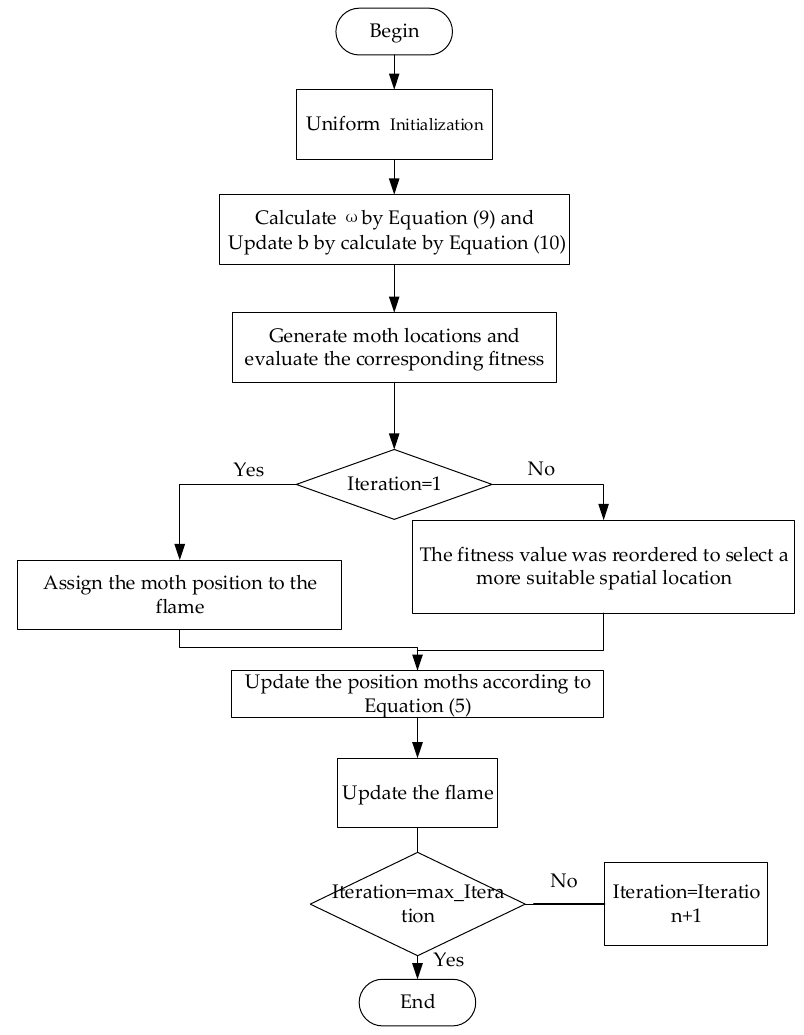
Figure 3. An enhanced moth-flame optimization algorithm (IUVMFO).